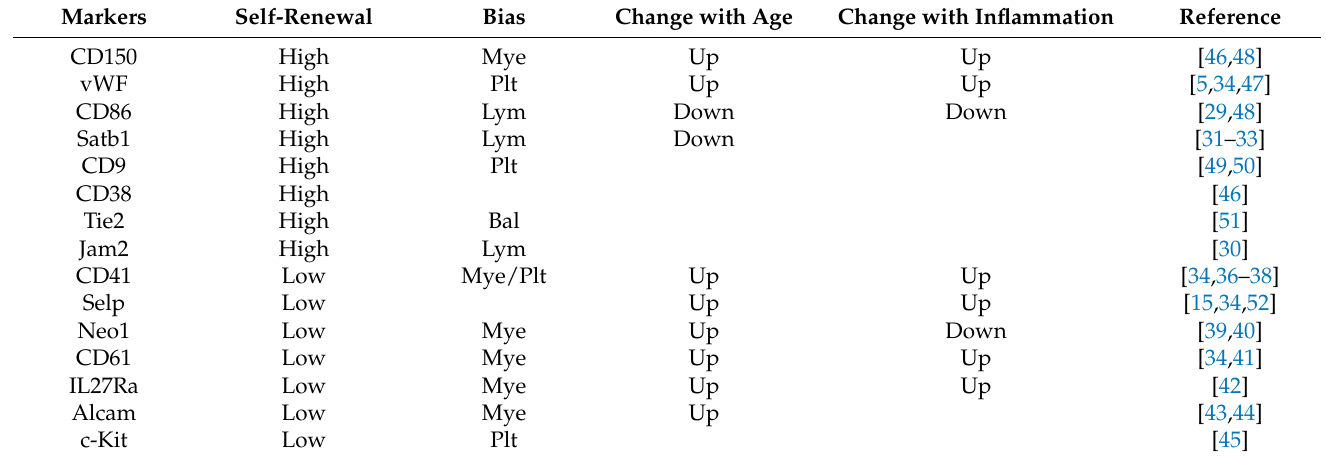
Table 1. Expression of HSC markers and their altered expression during aging or inflammation.